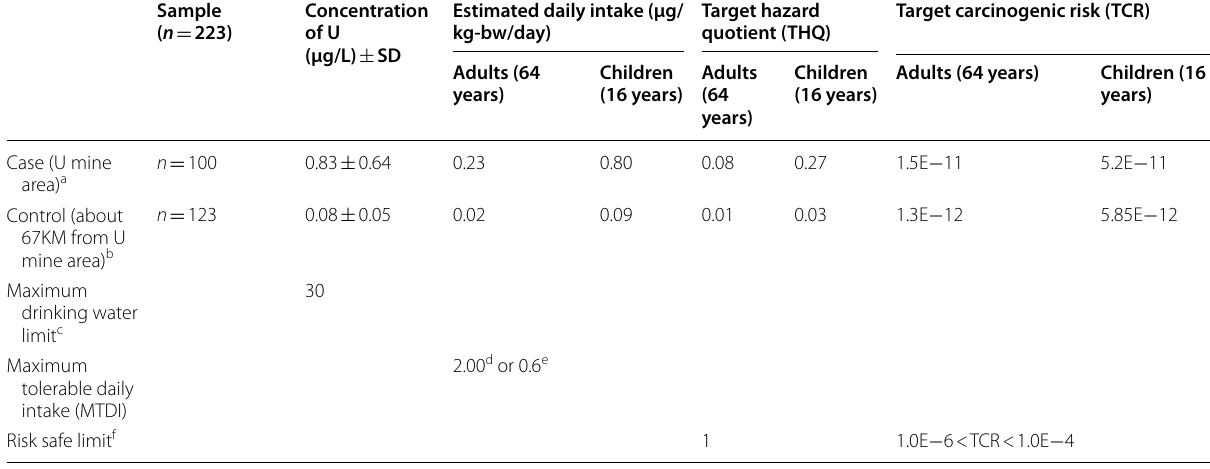
Table 2 Concentrations, cow milk estimated daily intakes, target hazard quotients and target carcinogenic risks of U consumed by Zambian adults and